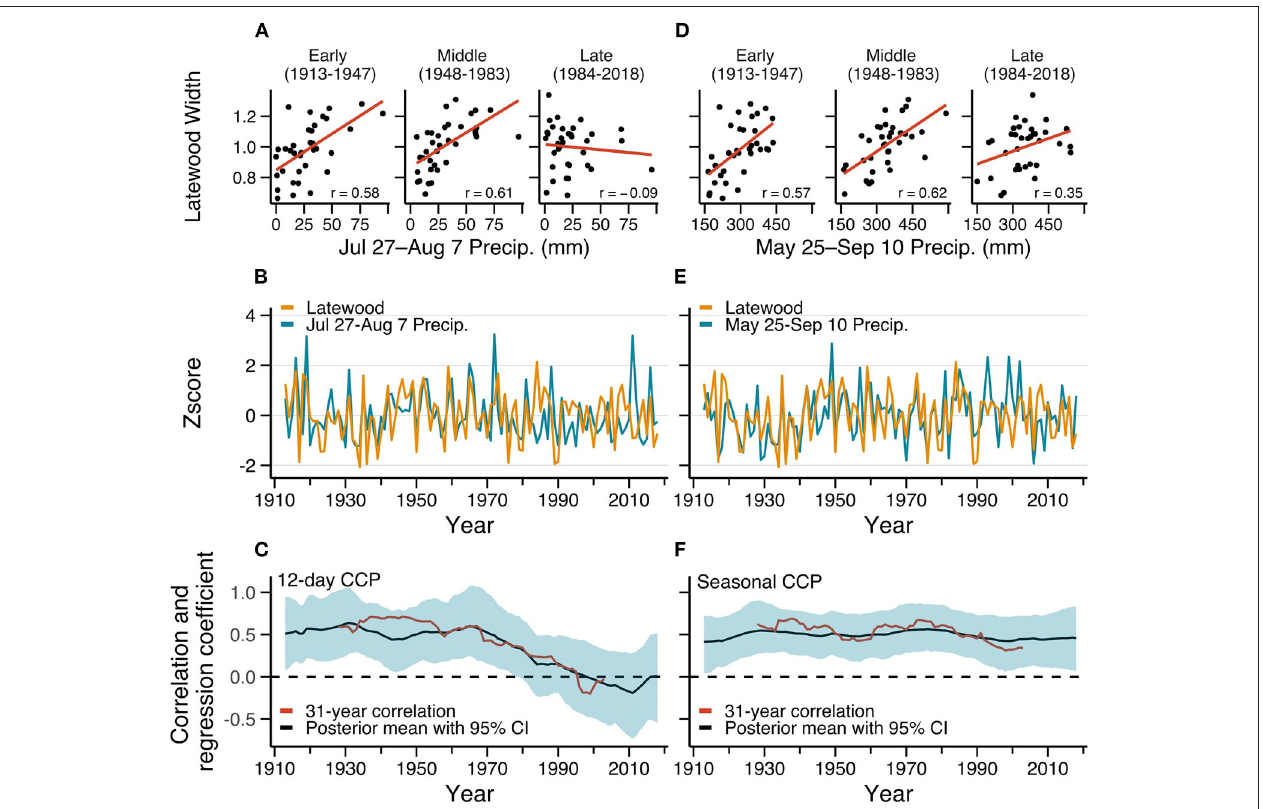
FIGURE 4 | Tree ring latewood vs. daily precipitation for the July 27–August 7 subseasonal (A–C) and the May 25–September 10 seasonal (D–F) windows determined to exhibit maximum covariance. Scatter plots illustrate the linearity of relationships for three non-overlapping periods spanning the full common period (A,D) . Timeseries plots illustrate z-scores for the data standardized over the 1912–2018 common period (B,E) . The bottom row (C,F) illustrates running 31-year correlations (red lines) and Bayesian generalized linear models of time varying coefficients (solid black lines). Blue shaded areas represent uncertainty estimated with 95% credible intervals for the regression